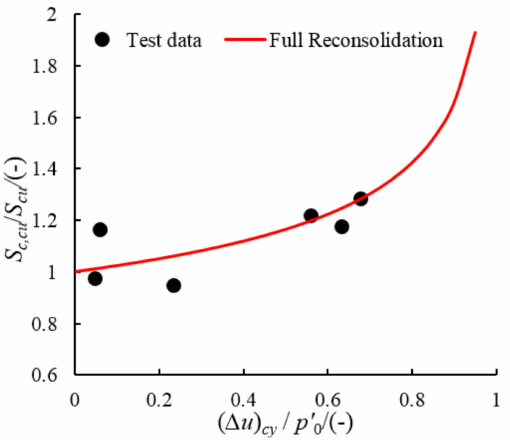
Figure 17. Comparison of predicted post-cyclic undrained shear strength and measured data for specimens with full